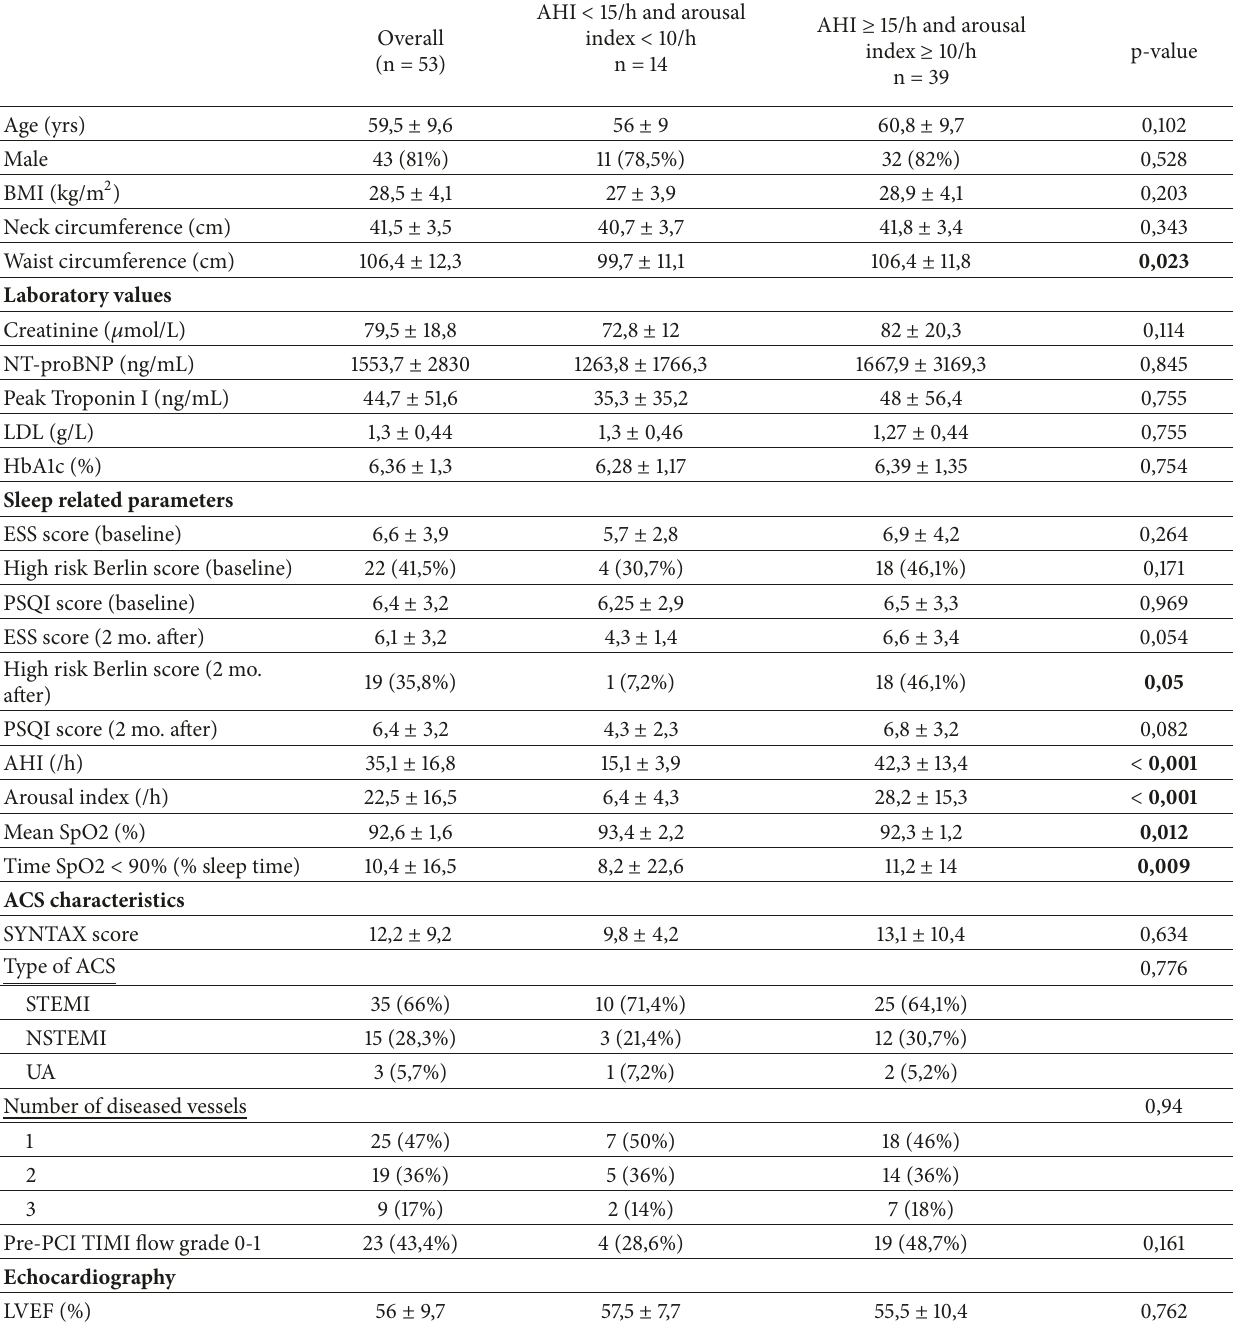
Table 1: Baseline characteristics of patients according to severity of OSA. Data are expressed as mean ± SD on number (%). ESS, Epworth SleepinessScale;PSQI,PittsburghSleepQualityIndex;AHI,apnea-hypopneaindex;STEMI,STelevationmyocardialinfarction;UA,unstable angina; PCI, percutaneous coronary intervention; LVEF, left ventricle ejection